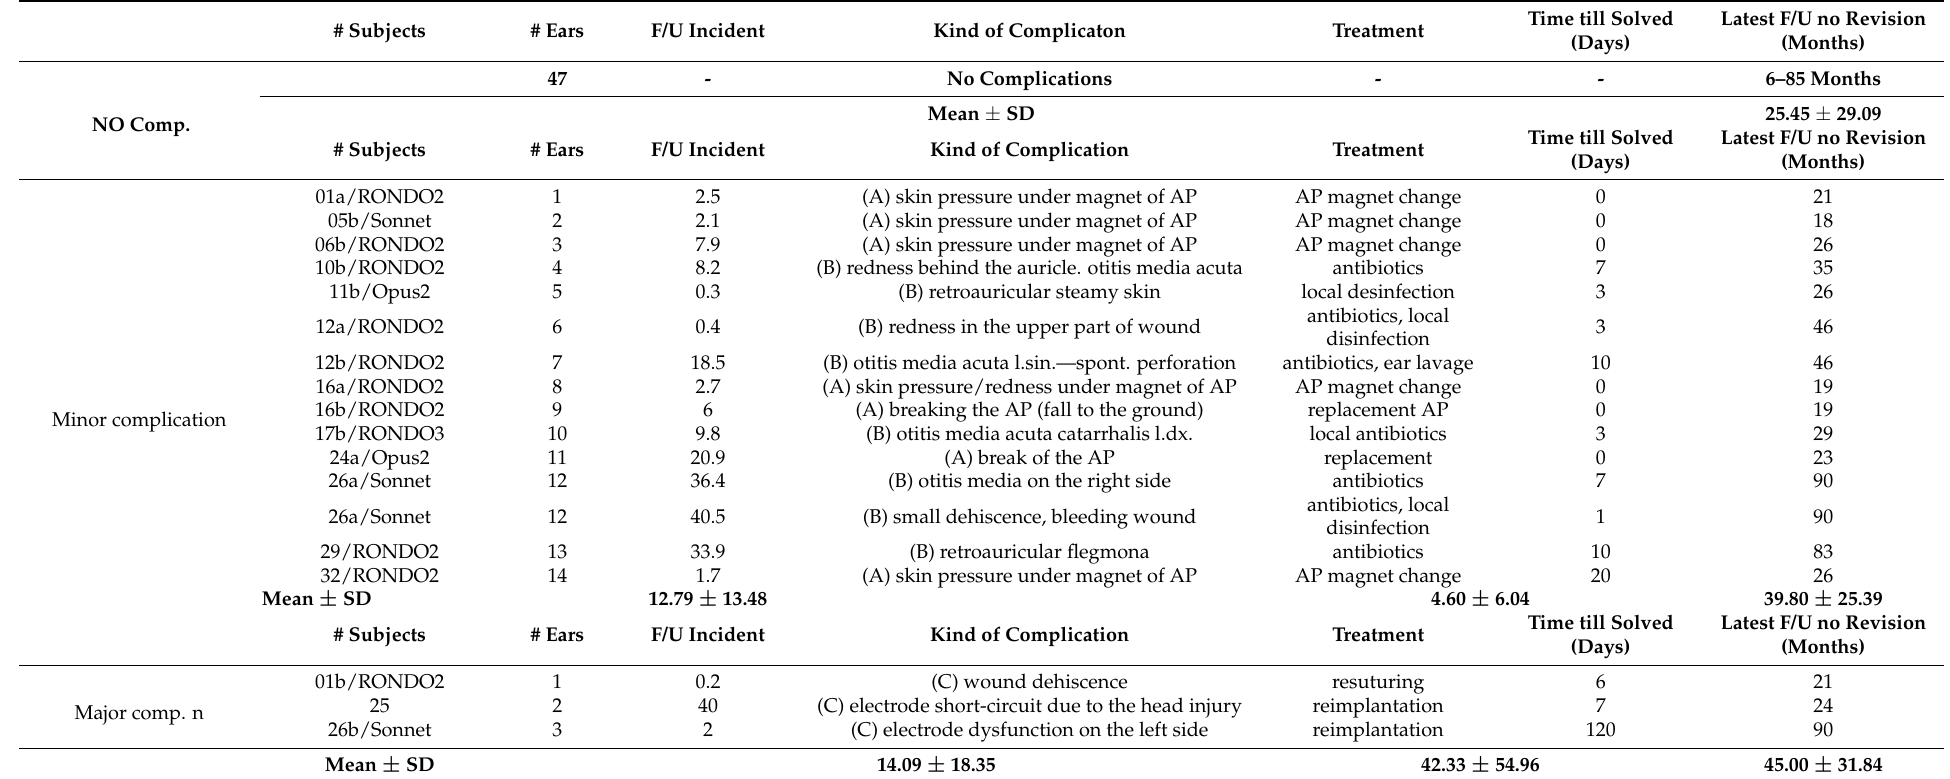
Table 3. Subjects with a complication presented in